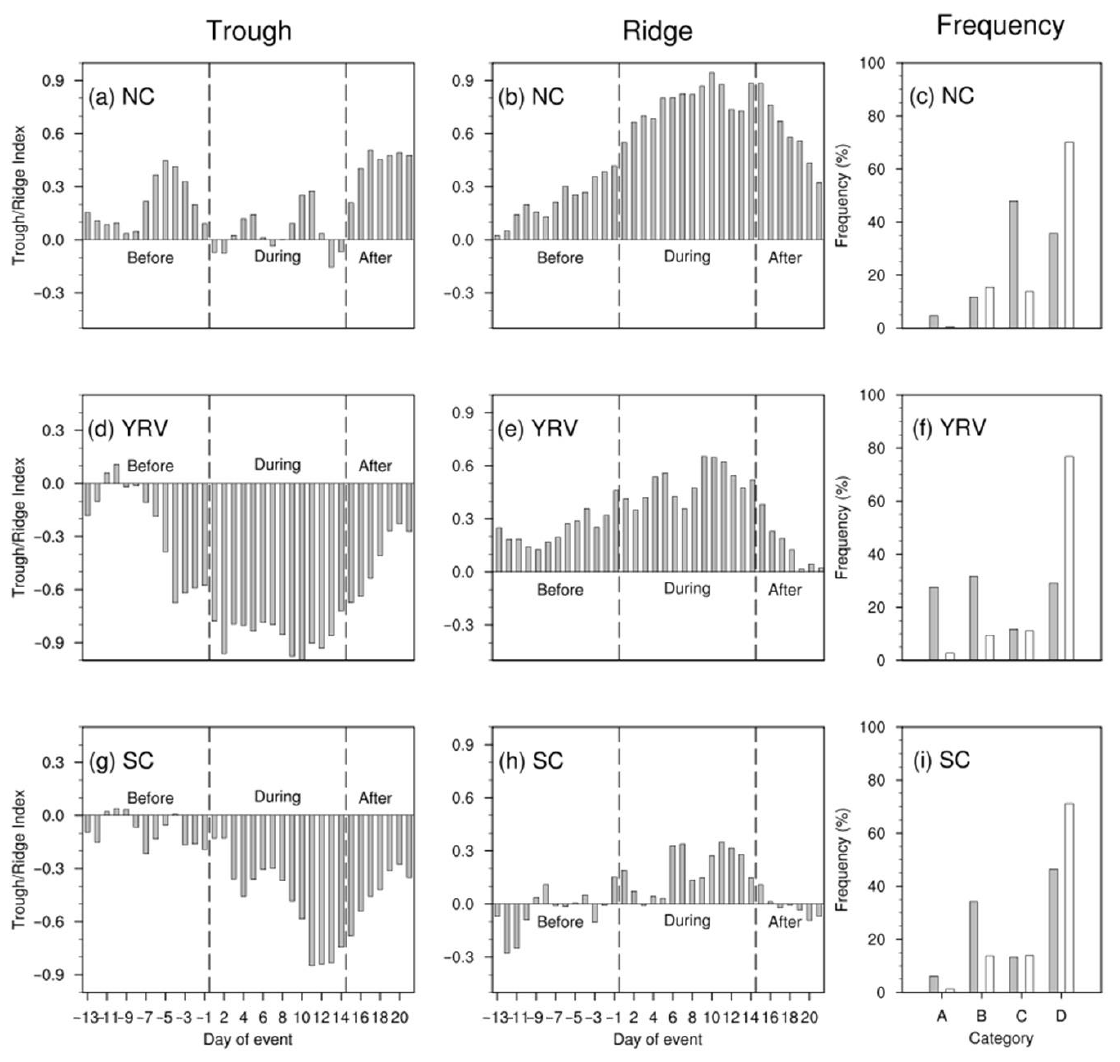
Figure 4. Eulerian trough and ridge statistics based on the area average of geopotential-height anomalies in the boxes in Figure 2. A time series of composites for the standardized anomalies for the ( a – c ) NC, ( d – f ) YRV, and ( g – i ) SC ridge areas before, during, and after events. There are four different types, with both trough and ridge magnitudes exceeding the standard deviation, noted as category A. If the amplitude of the trough exceeds the standard deviation but the amplitude of the ridge does not exceed it, it is classified as category B. A ridge whose amplitude exceeds the standard deviation but the amplitude of the trough is not exceeded is classified as category C. Both trough and ridge amplitudes did not exceed the standard deviation and were recorded as category D. 3.3. Atmospheric Rivers According to [34], the forecast of persistent strong rainstorms needs to focus on two aspects. On the one hand, we should pay attention to the circulation type that is prone to produce heavy rain, and more importantly, we should pay attention to the establishment of a strong monsoon moisture conveyor belt or AR. Next, we will explore the contribution of ARs to 14-day PEPEs in different regions. It has been previously understood in Figure 4 that one of the common features of 14-day PEPEs when they occur is the presence of anomalies in the IVT of the storm area. A study